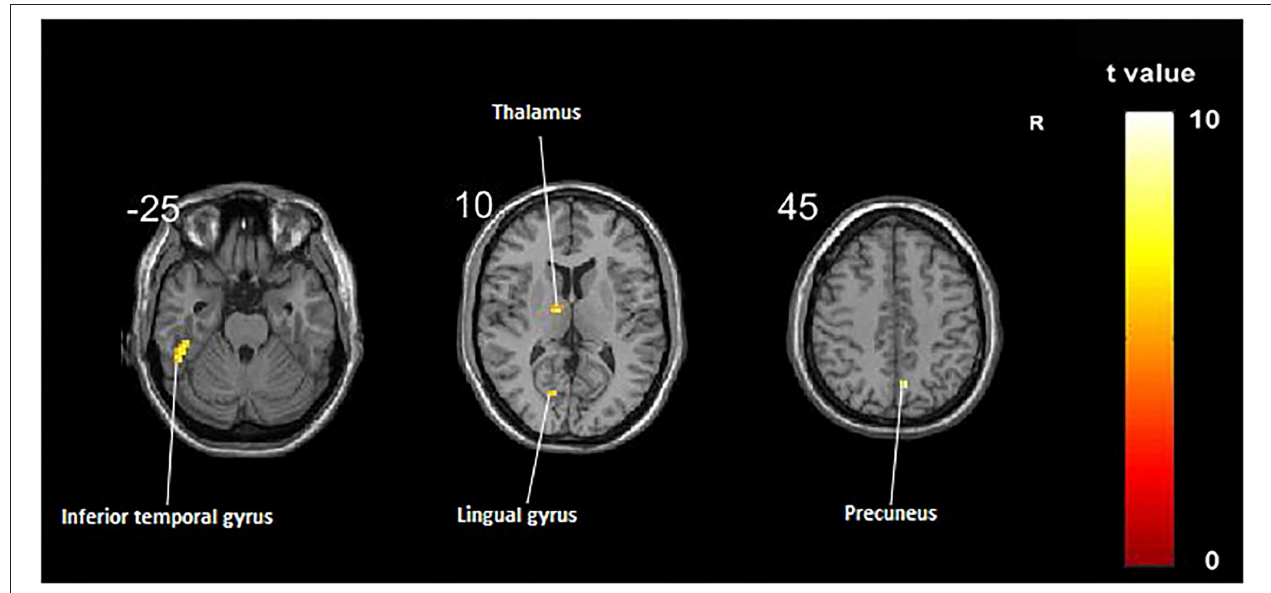
FIGURE 2 | Regions showing significant fALFF value changes between the treatment group and control group. The results were uncorrected with p < 0.001.